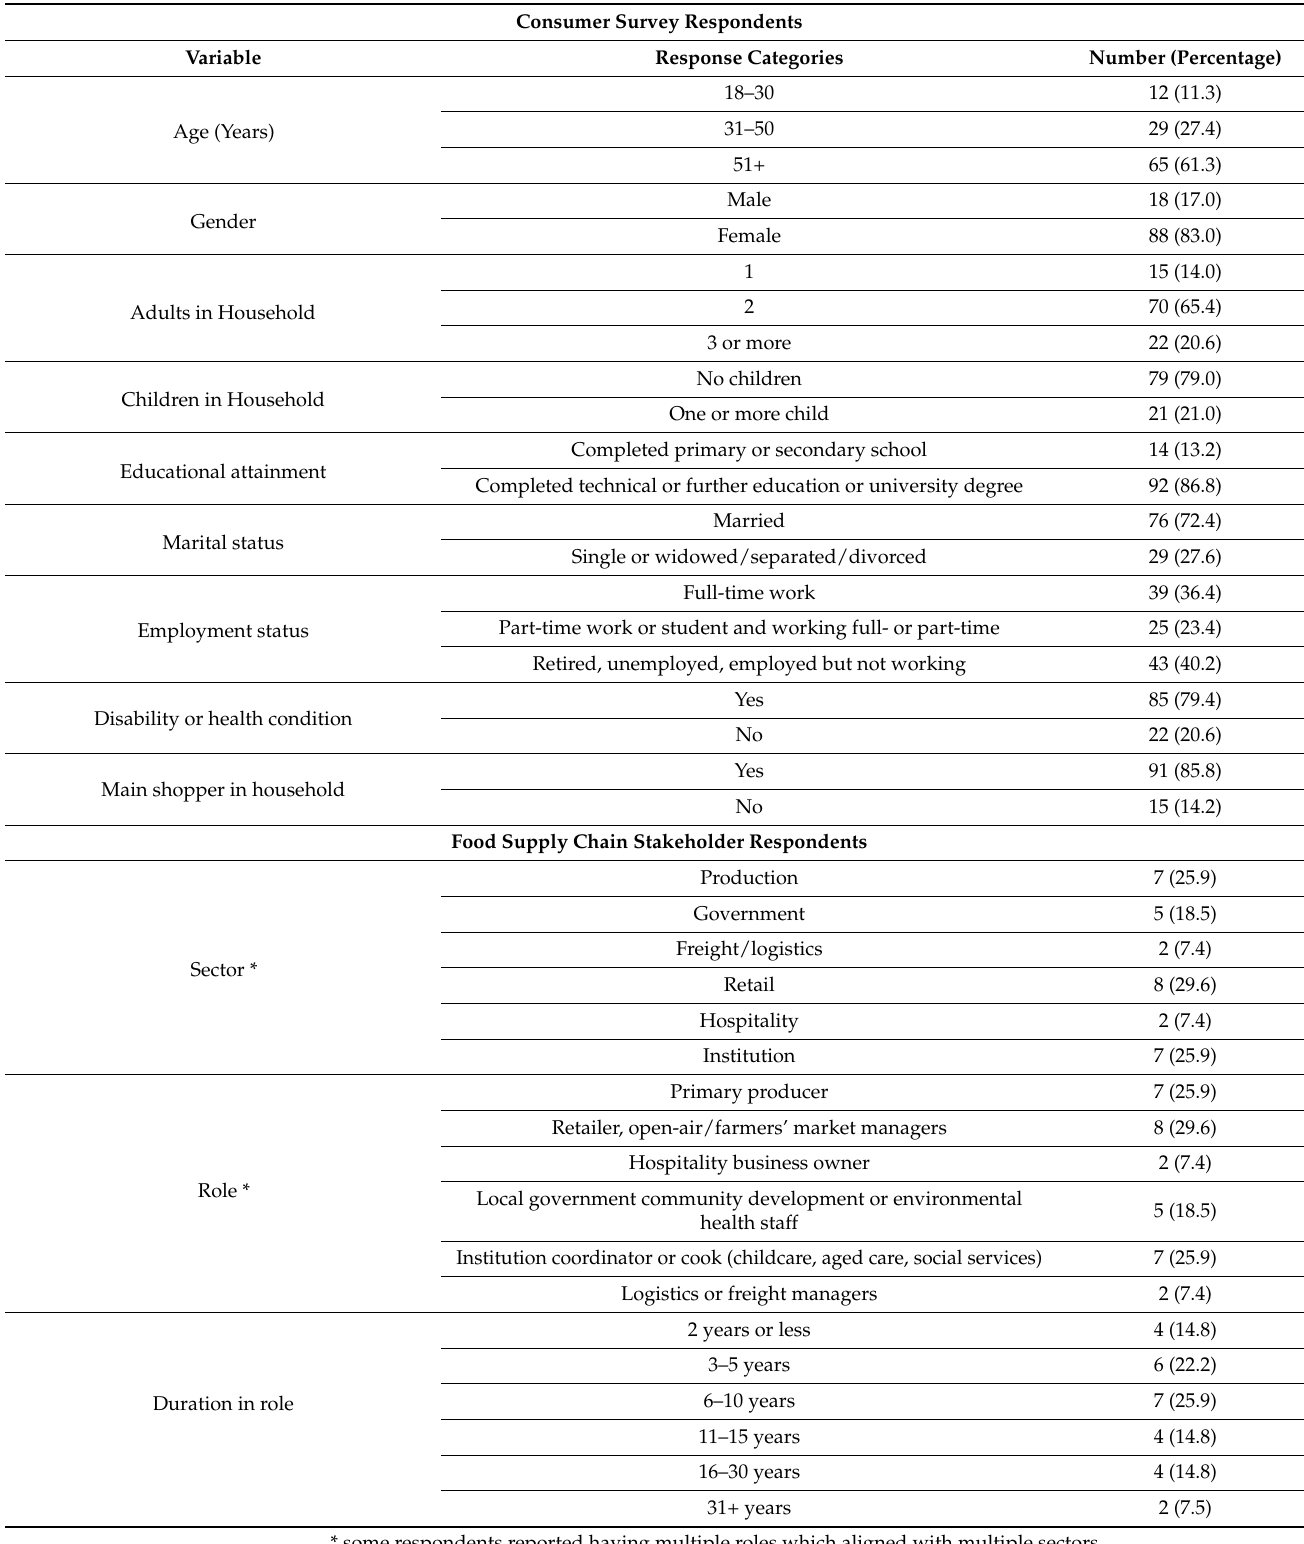
Table 2. Phase 1 consumer survey and Phase 2 stakeholder interview participant